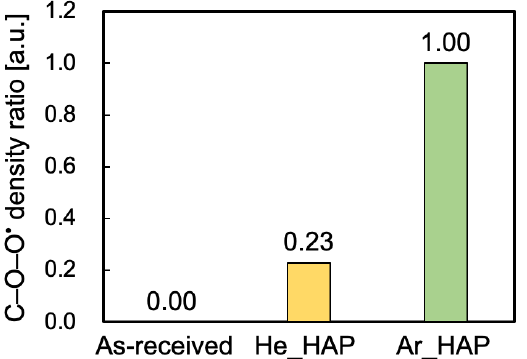
Figure 3. Peroxy radical density ratios calculated from the ESR spectra of the PTFE samples HAP- treated using He or Ar gas. Each radical density ratio was normalized based on the ESR spectrum of the PTFE samples HAP-treated using Ar gas.